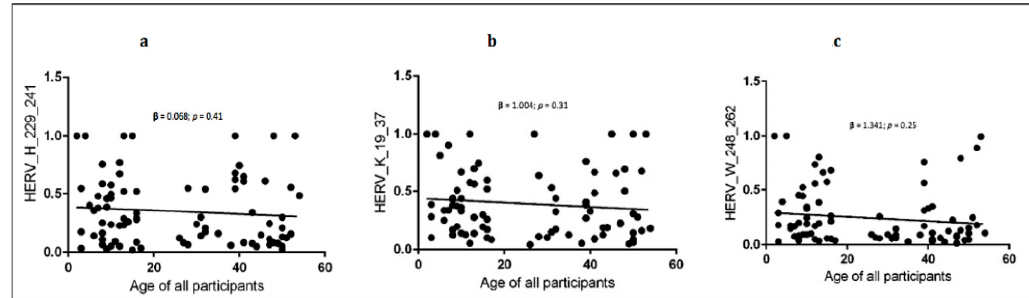
Figure 1. Heatmap displaying the r values obtained from Spearman’s correlation analysis performed among HERV-H-, HERV-W- and HERV-K-derived epitopes in ASD children ( A ) and in HC children ( B ).